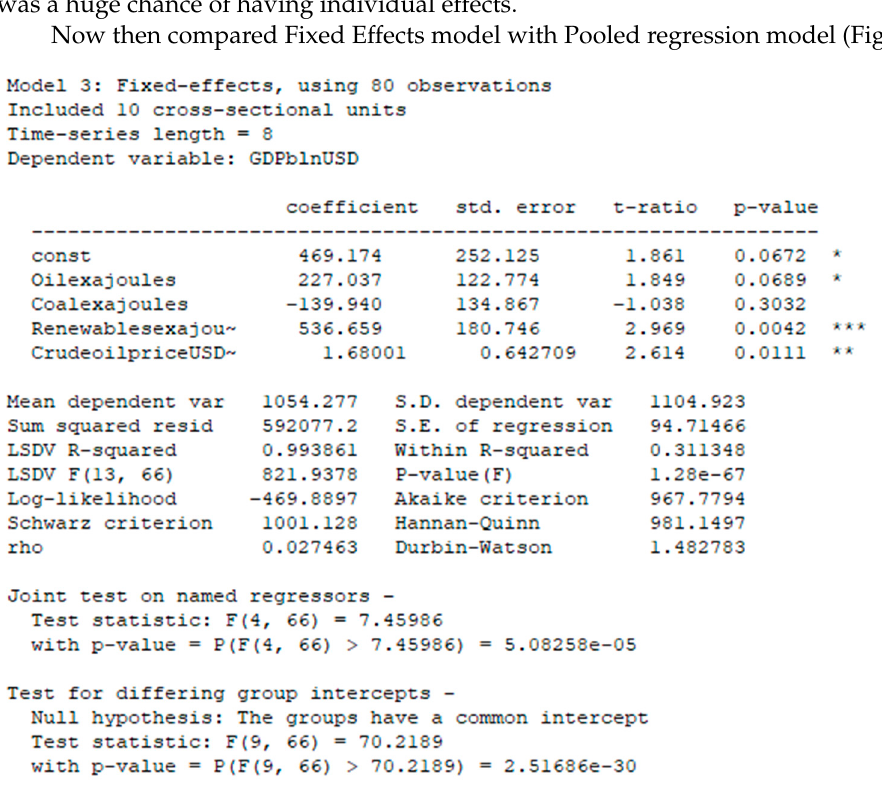
Figure 5. Testing Pooled regression models.